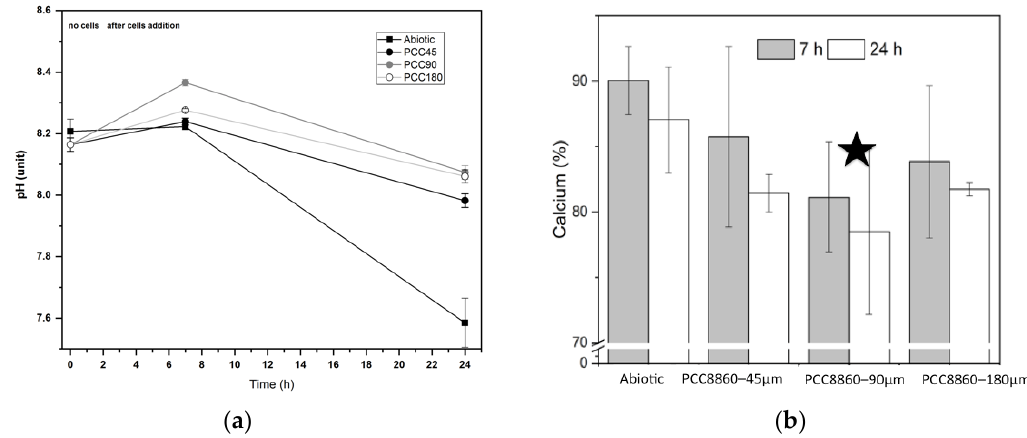
Figure 4. ( a ) Dynamics of pH in the abiotic conditions and in the presence of Syn. PCC8806 biomass. Data collected after 7 and 24 h. ( b ) Measured dissolved calcium (%) of the initial calcium concentration at different stages of the experiment (3 replicates). The initial molar concentration of calcium was 2.52 mM. The changes in Syn . PCC8806-90 μ m solutions were found to be statistically significant: A star indicates this.